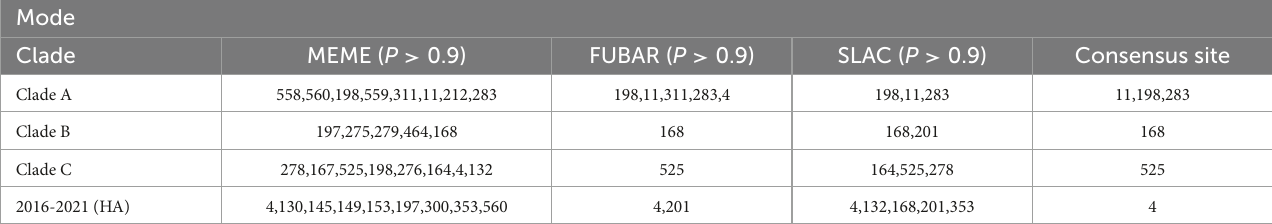
TABLE 3 Positive selection pressure sites for the HA gene of H9N2 viruses. Mode